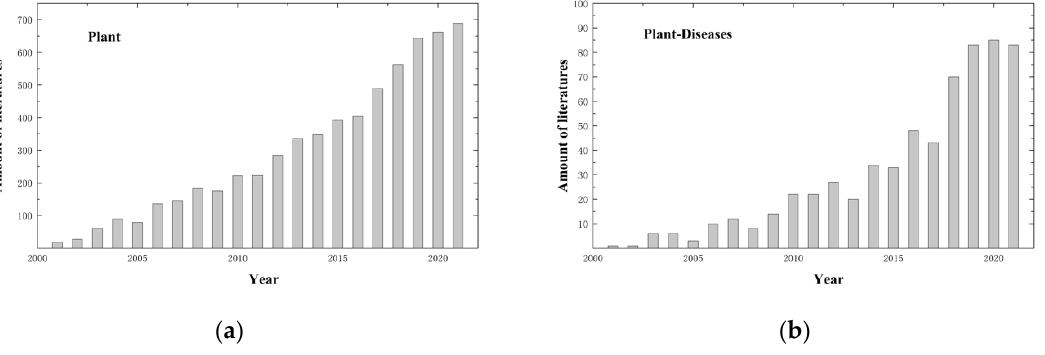
Figure 1. Number of published relevant literature records each year. ( a ) Keywords “hyperspectral” and “plants”; ( b ) keywords “hyperspectral”, “plants”, and “disease”. (2) In a search of the subject “disease” in the results of (1), 621 literature records were obtained. The time distribution of their publication is shown in Figure